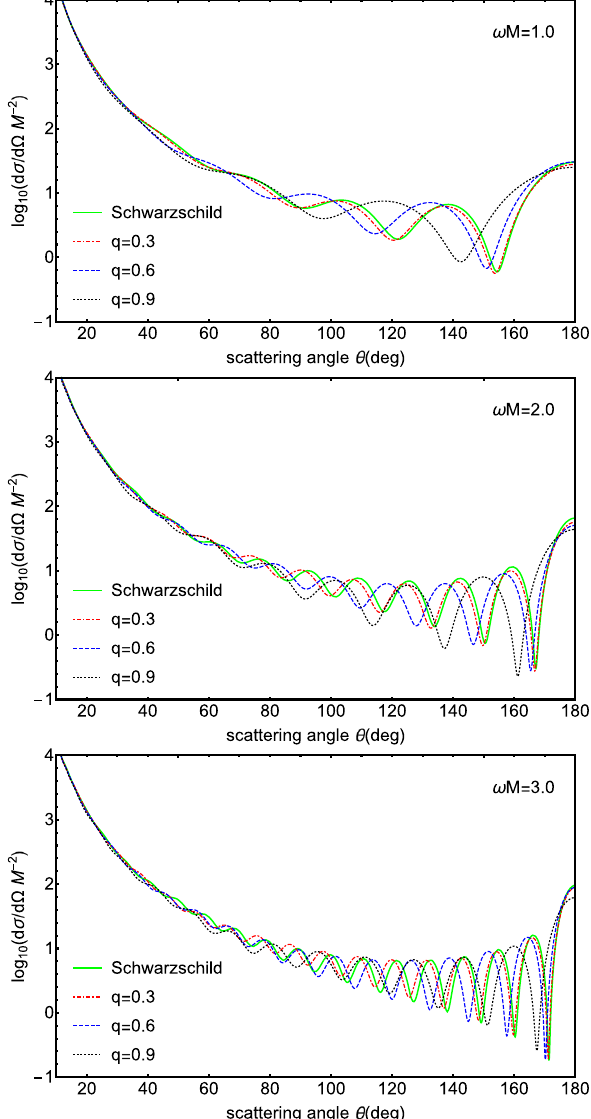
Fig. 6 Comparison of scattering cross sections with ω M = 1 . 0 (top), 2.0 (middle), and 3.0 (bottom), for different values of the black hole